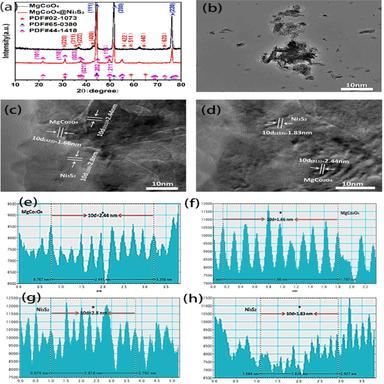
(a) XRD patterns of the MCO@NS and MCO electrodes. (b) TEM images of MCO@NS and (c, d) HRTEM of MCO@NS and relevant intensity profiles for the line scans across the lattice fringes: MCO electrode (e and f), NS (g and h).